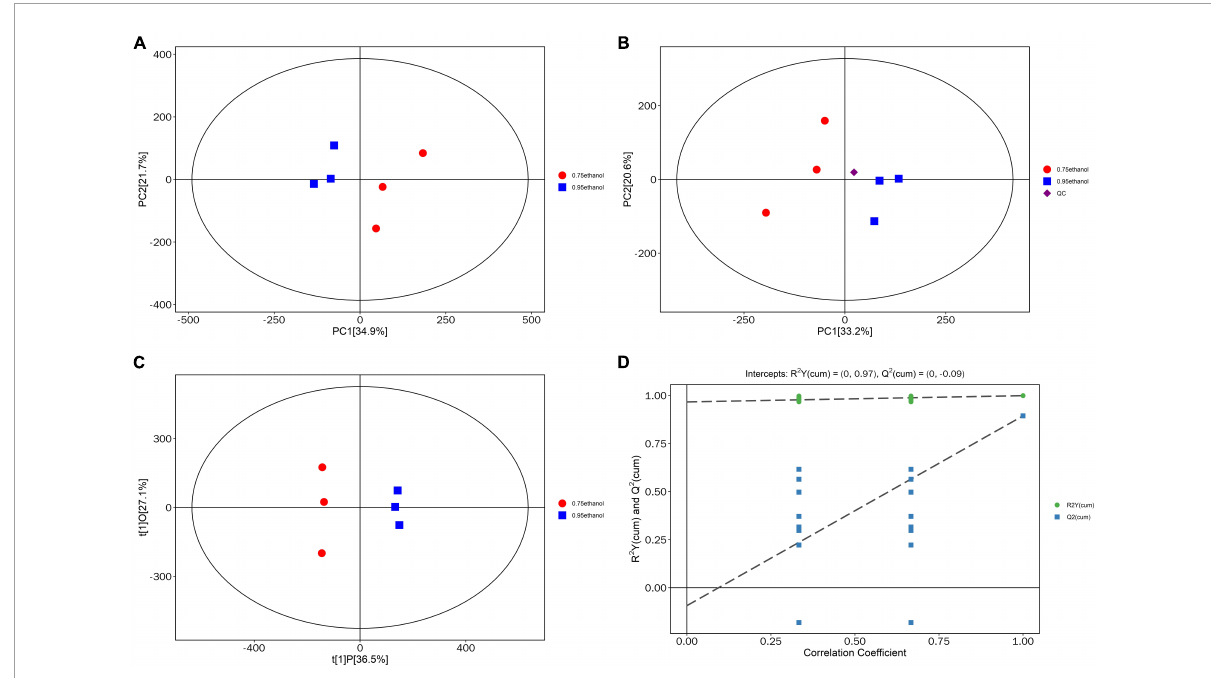
FIGURE4 Principal component analysis (PCA) score plot. (A) Score scatter plot of PCA model for group 95% ethanol vs. 75% ethanol. (B) Score scatter plot for PCA model total with QC. (C) Score scatter plot of OPLS-DA model for group 95% ethanol versus 75% ethanol. (D) Permutation test of OPLS-DA model for group 95% ethanol versus 75%